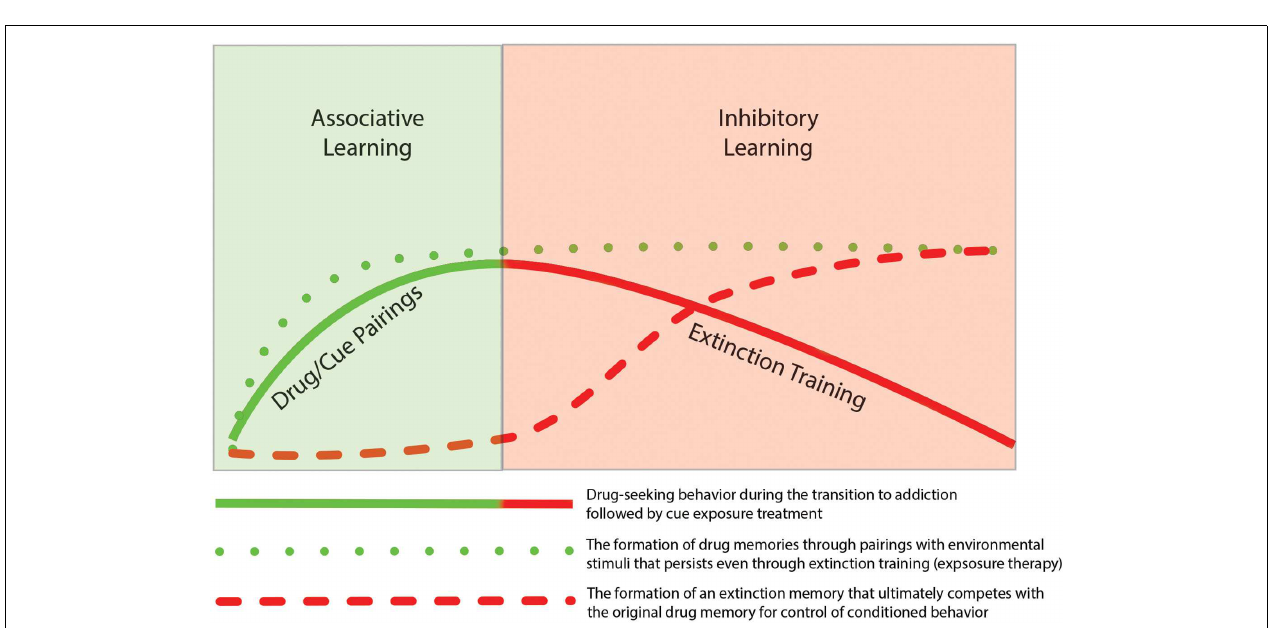
trace remains long after discontinuation of drug-taking.The extinction of drug-seeking by pairing unreinforced exposure of drug-related cues, does not result in the deletion of the original drug memory, but instead involves the formation of a new inhibitory “extinction memory.”While this new memory provides inhibitory drive over drug-seeking behavior in the short term, the original drug-memory remains, which may explain the high rate of relapse following behavioral extinction therapies.